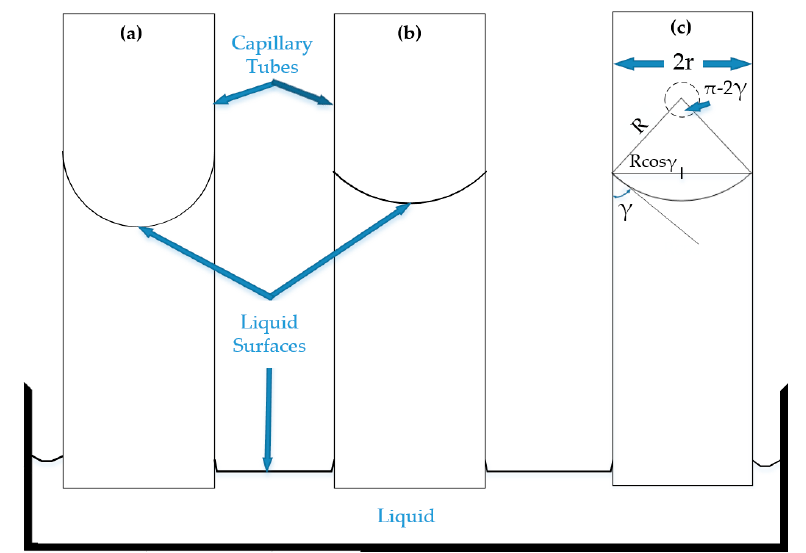
Figure 6. Effect of contact angle on capillary action pulling up the liquid inside the capillary tubes with the same radii. ( a ) Zero contact angle between the liquid and the tube; ( b ) nonzero contact angle between the liquid and the tube, modified from [72]; ( c ) geometric representation of the shape of the meniscus, radius of curvature (R) to the radius of the capillary (r) and the contact angle ( γ ), modified from [73].